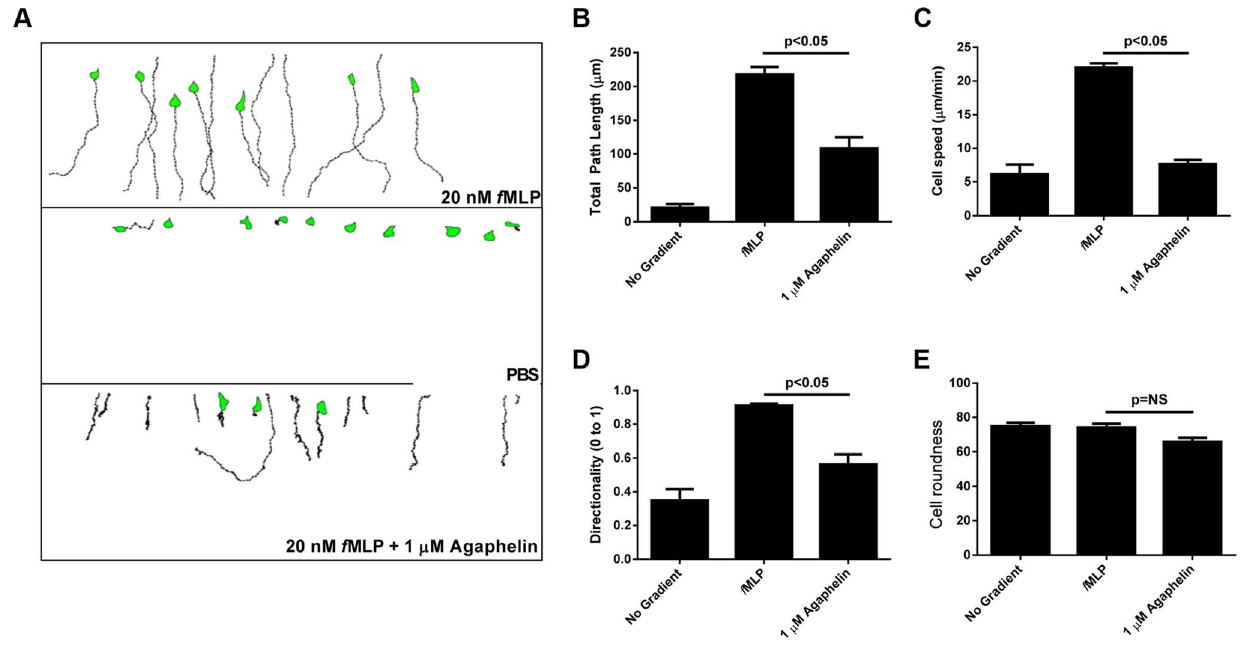
Figure 3. Agaphelin inhibits neutrophil chemotaxis invitro . A) Chemotaxis of HL60 cells in EZ-TAXIScan chambers. Upper panel: HL60 cells incubated with PBS and then exposed to fMLP (20 nM) concentration gradient. Middle panel: HL60 cells incubated with buffer only and not exposed to f MLP. Lower panel: HL60 cells incubated with Agaphelin (1 m M) for 1 h and exposed to f MLP (20 nM). B–E) Quantification. Cell migration was analyzed based on the results presented in (A) and plotted for the following parameters: B) Total path length; C) Cell speed; D) Directionality, and E) Cell roundness. Data are expressed as the mean 6 S.E (*, p # 0.05; t -test).